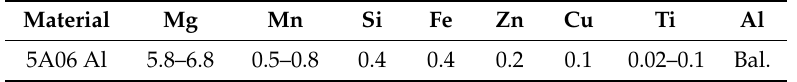
Table 2. Chemical composition of 5A06 Al alloy (wt %).